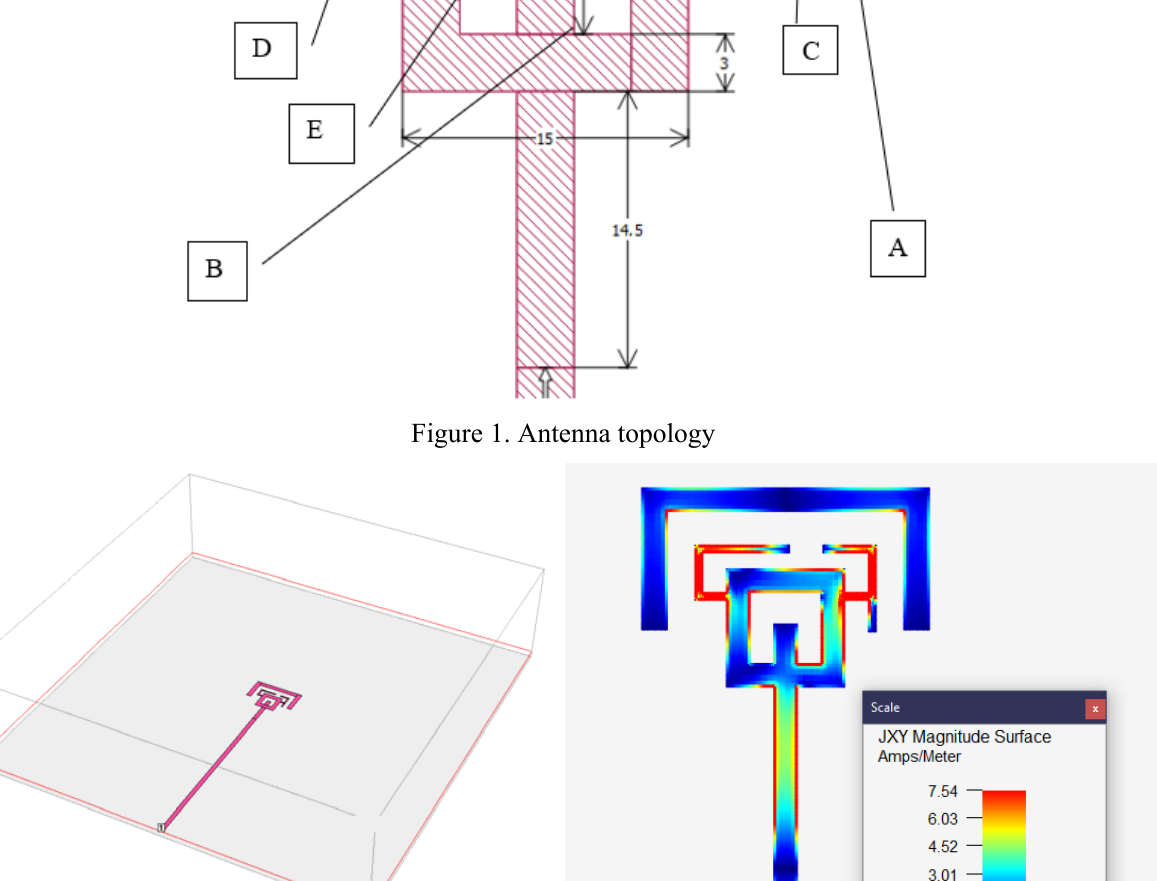
Figure 2. 3D antenna topology